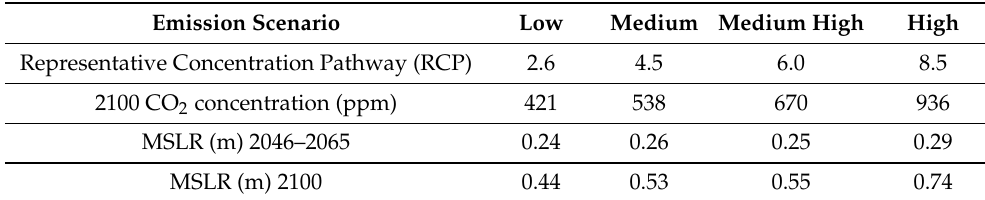
Table 5. Projections of global mean sea level rise. Emission Scenario